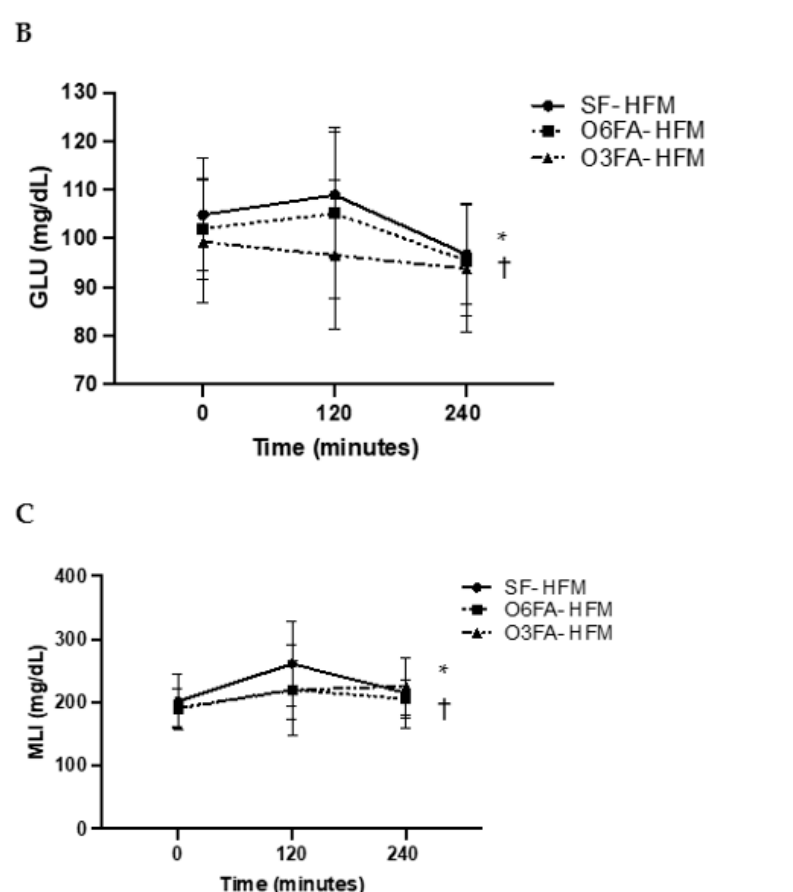
Figure 1. ( A – C ). Postprandial metabolic responses. Metabolic responses in the three smoothie conditions are displayed as a mean ± SE for baseline, 2 h (120 min), and 4 h (240 min). TRGs ( A ), GLU ( B ), and MLI ( C ) are displayed with the SF-HFM in shaded black circle, the O6FA-HFM in black squares, and the O3FA-HFM in black triangles. * Indicates significance across time points, and † indicates significance as an interaction between smoothie type and time point.